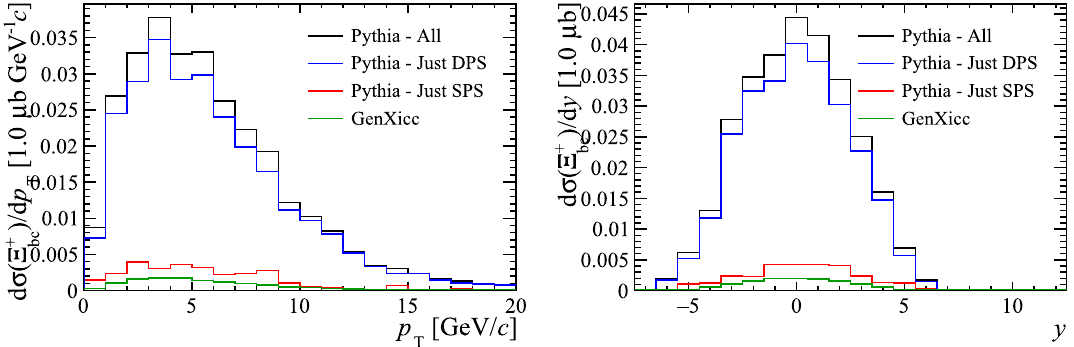
Fig. 14 Kinematic distributions of (cid:2) +